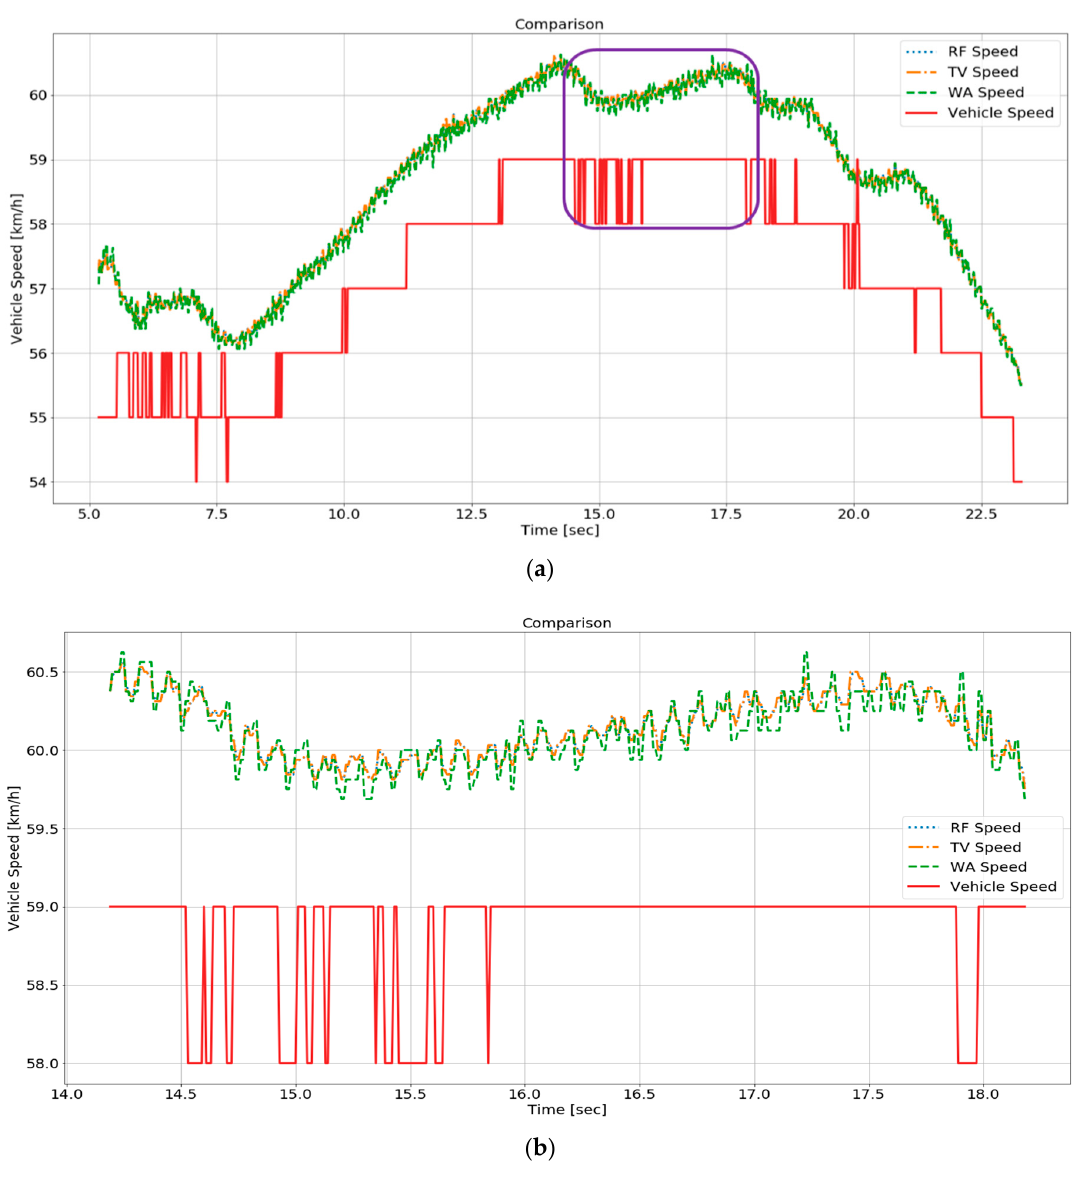
Figure 9. Comparison of fusion algorithms during constant speed: ( a ) Constant speed; ( b ) Vehicle speed and estimated speed.